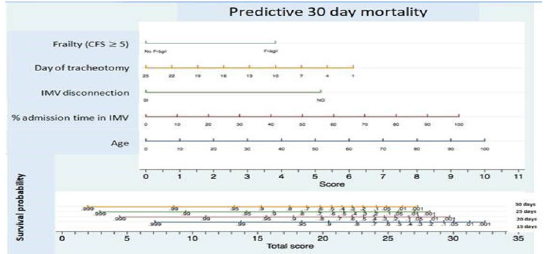
Fig. 1 (abstract 000912). See text for description